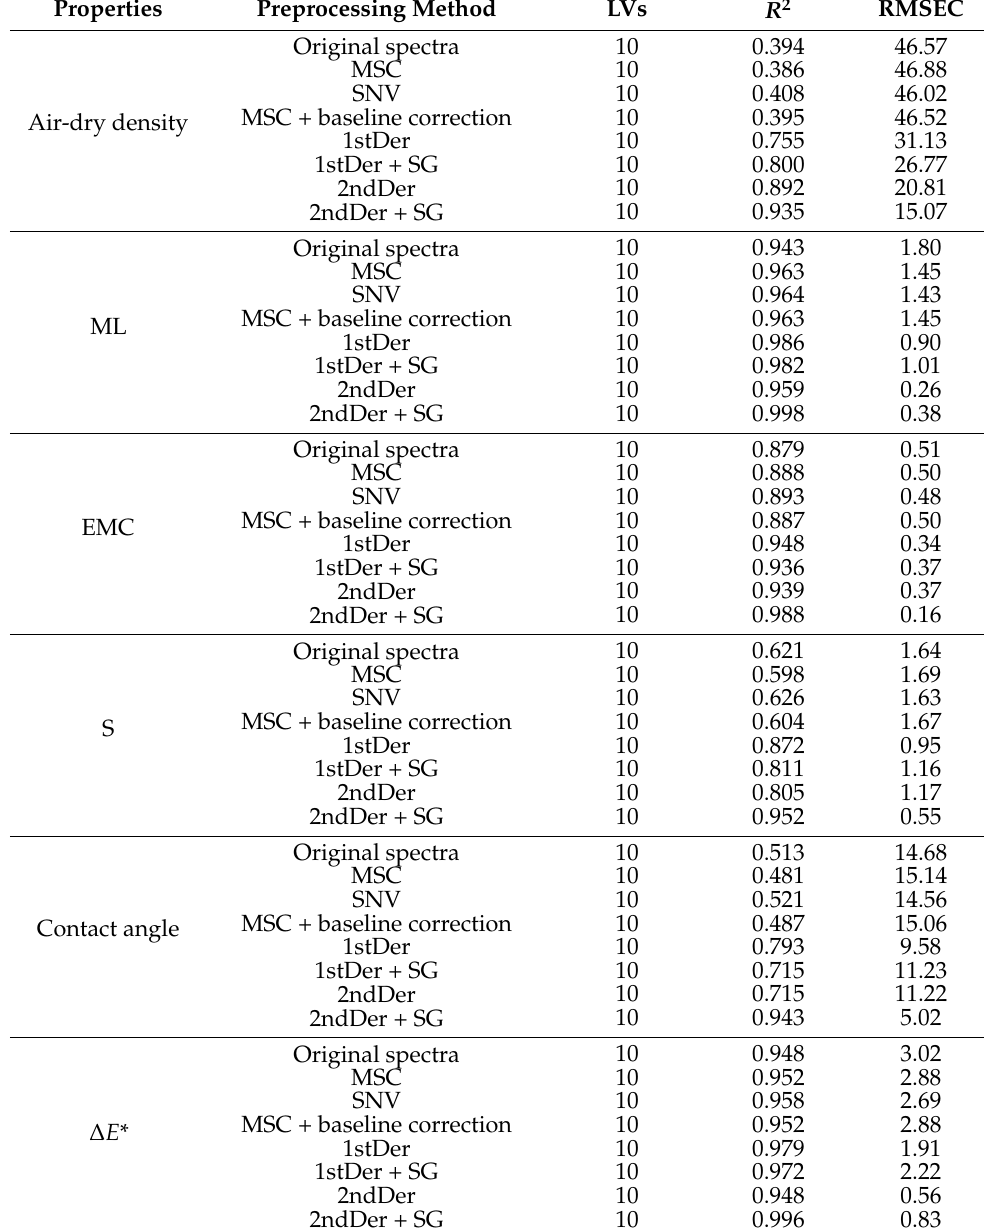
Table 3. Results of PLSR model by different preprocessing